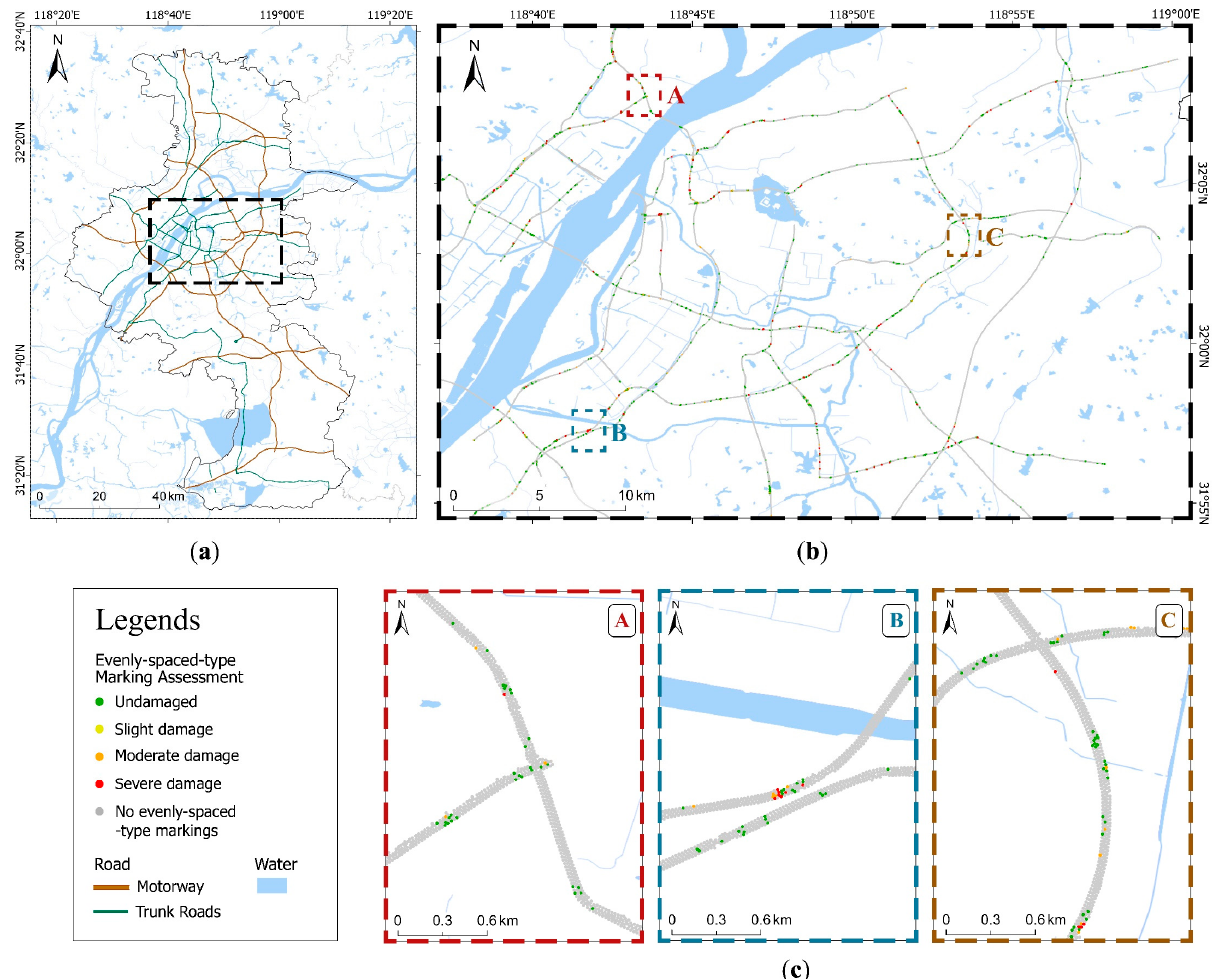
Figure 11. The assessment results for evenly spaced-type pavement markings of each sampling point in Nanjing. ( a ) Location of detected roads in Nanjing, ( b ) an overview of the assessment results of evenly-spaced-type markings, and ( c ) a detailed display of the marked areas in panel ( b ).